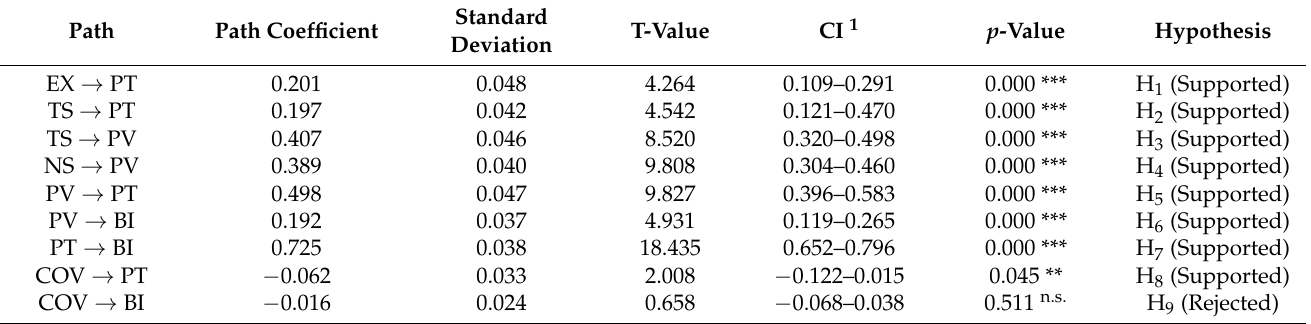
Table 3. Path coefficients of the structural equations